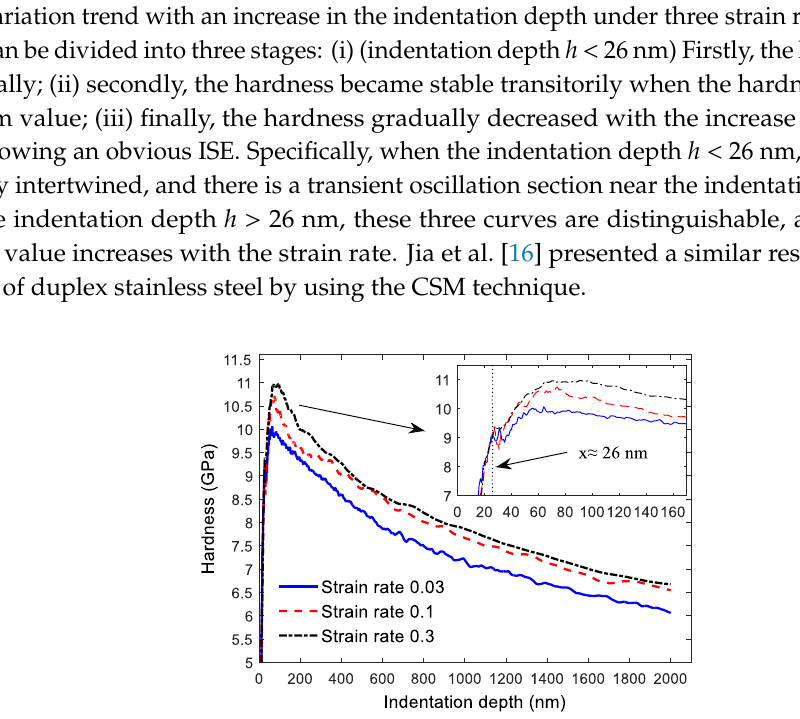
Figure 3. Hardness vs. indention depth for the three strain rates of 0.03, 0.1 and 0.3 s − 1 .